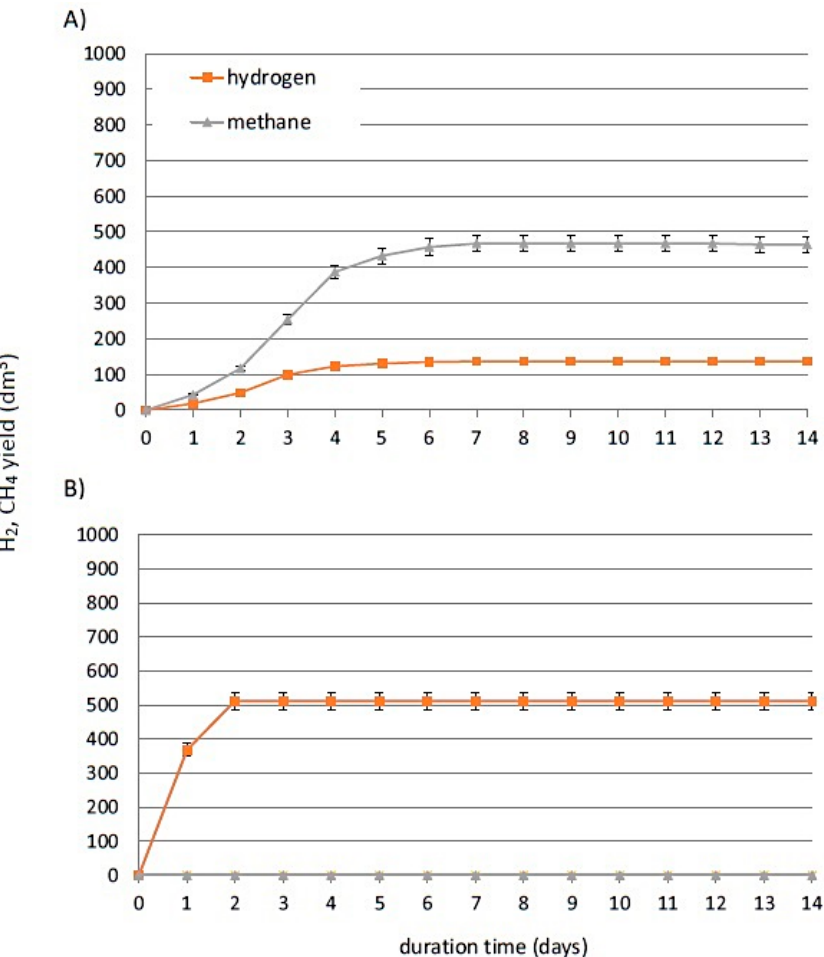
Figure 3. Cumulative hydrogen and methane production for TASBP-1 without pretreatment ( A ) and with pH adjustment followed by thermal pretreatment ( B ).